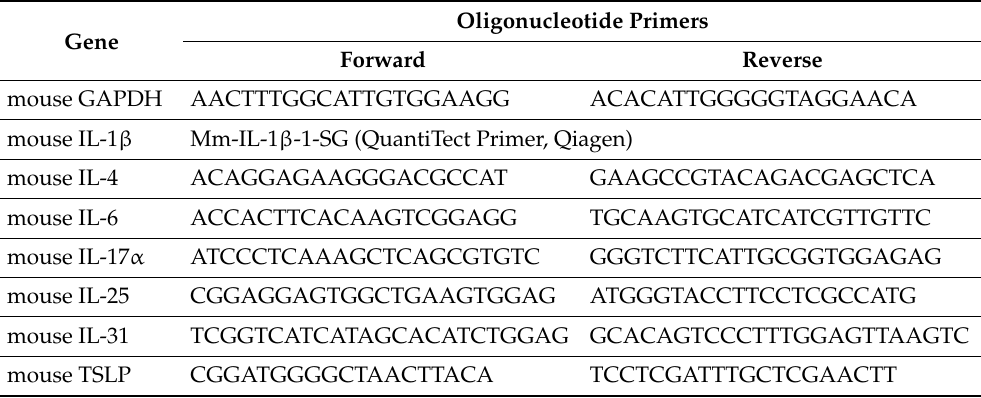
Table 1. Real-Time PCR primers used in this